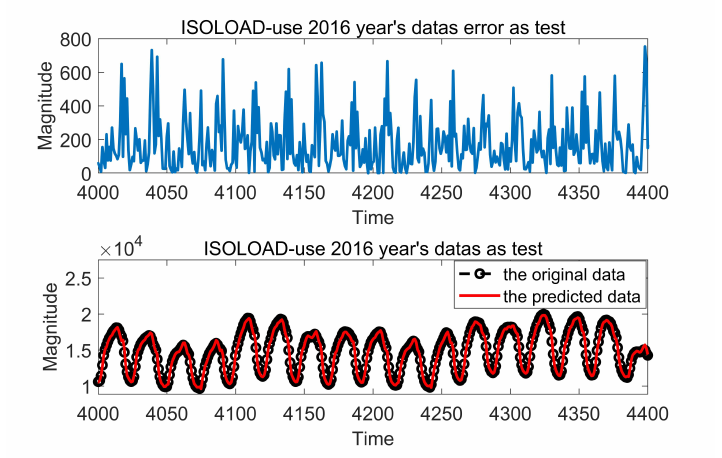
Figure 4. The total load prediction results and AE curves of the proposed LF-NSNP model for 2016.